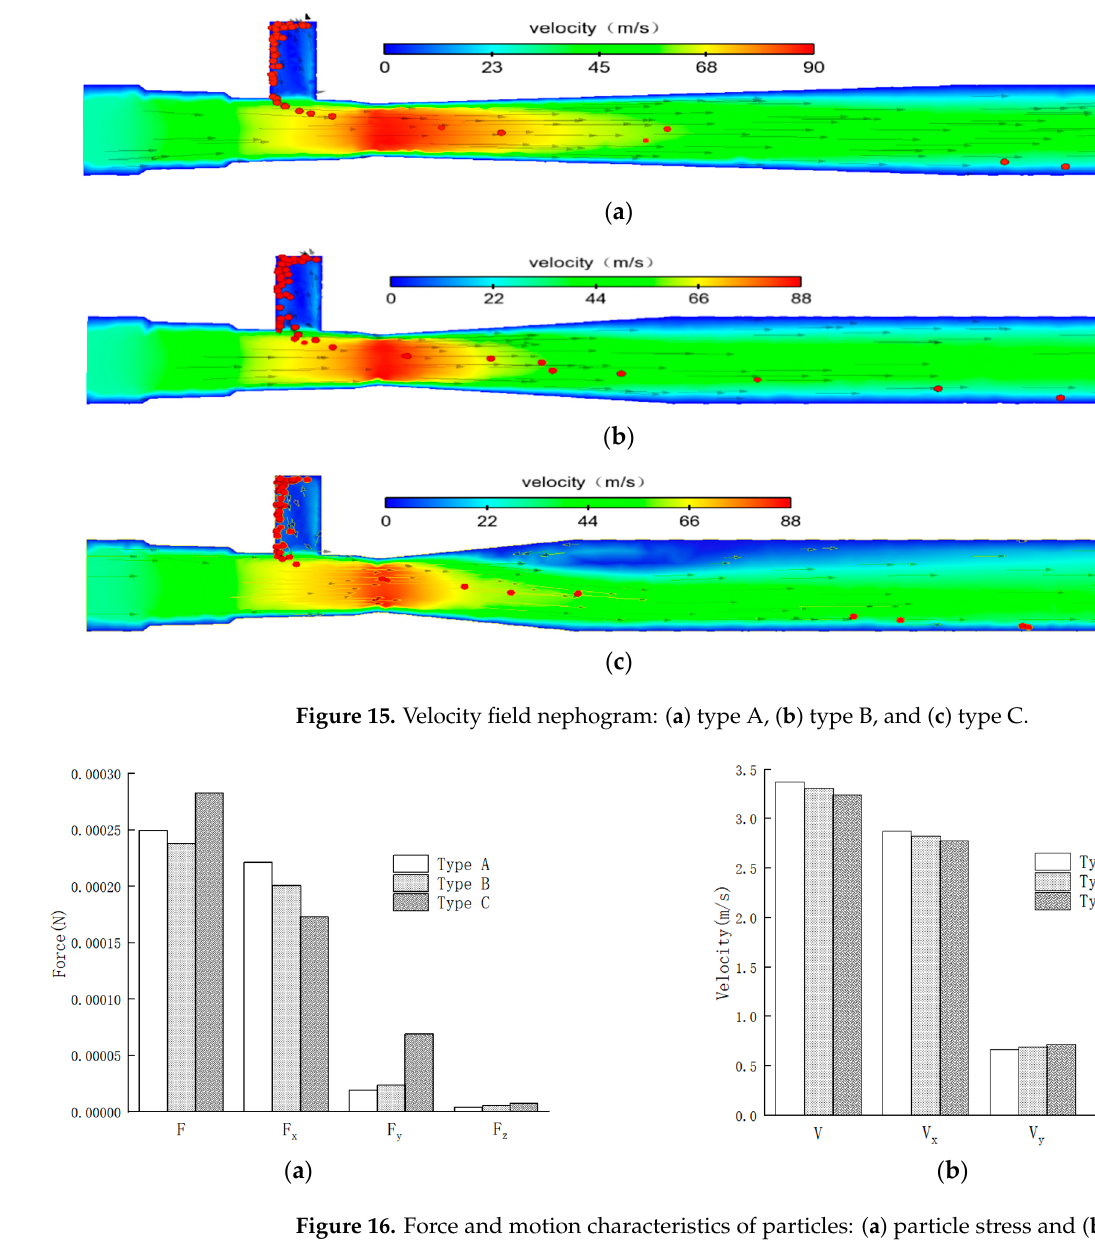
Figure 14. Dynamic pressure field nephogram: ( a ) type A, ( b ) type B, and ( c ) type C.